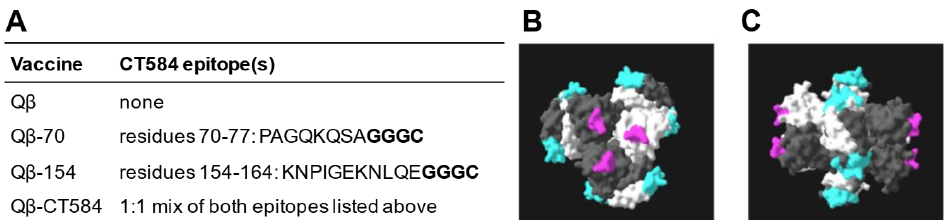
Figure 1. Development of virus-like particle vaccines against C. trachomatis T3SS tip protein CT584. ( A ) Linear B-cell epitopes of C. trachomatis CT584 were identified by the Immune Epitope Database and used in VLP vaccines. Bolded residues were added for chemical conjugation to the VLP composed of the capsid from the bacteriophage Q β . ( B , C ) Localization of vaccine epitopes 70–77 (pink) and 154–164 (cyan) in the CT584 hexamer from the top ( B ) and side ( C ) view. Structure retrieved from NCBI PDB